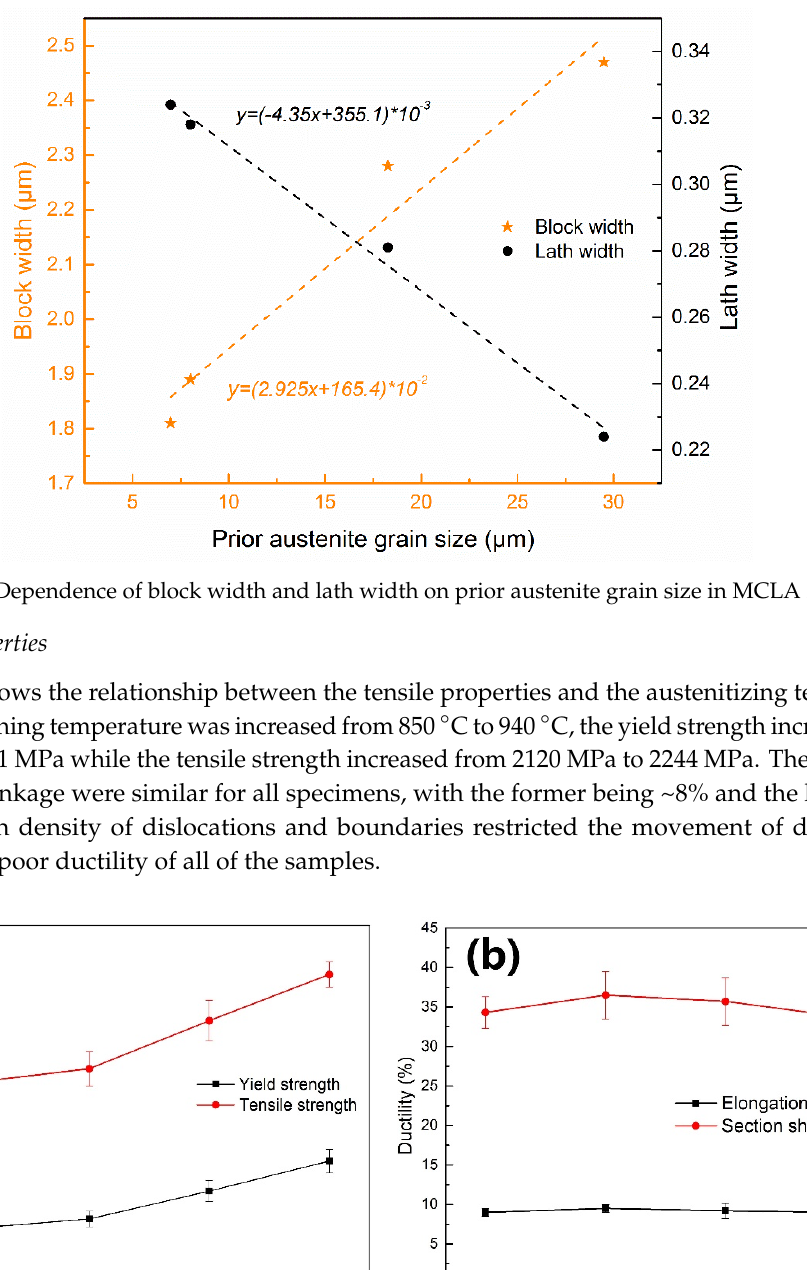
Figure 8. Tensile properties of MCLA martensite steel at different austenitizing temperatures: ( a ) yield strength and tensile strength; ( b ) elongation and section shrinkage.